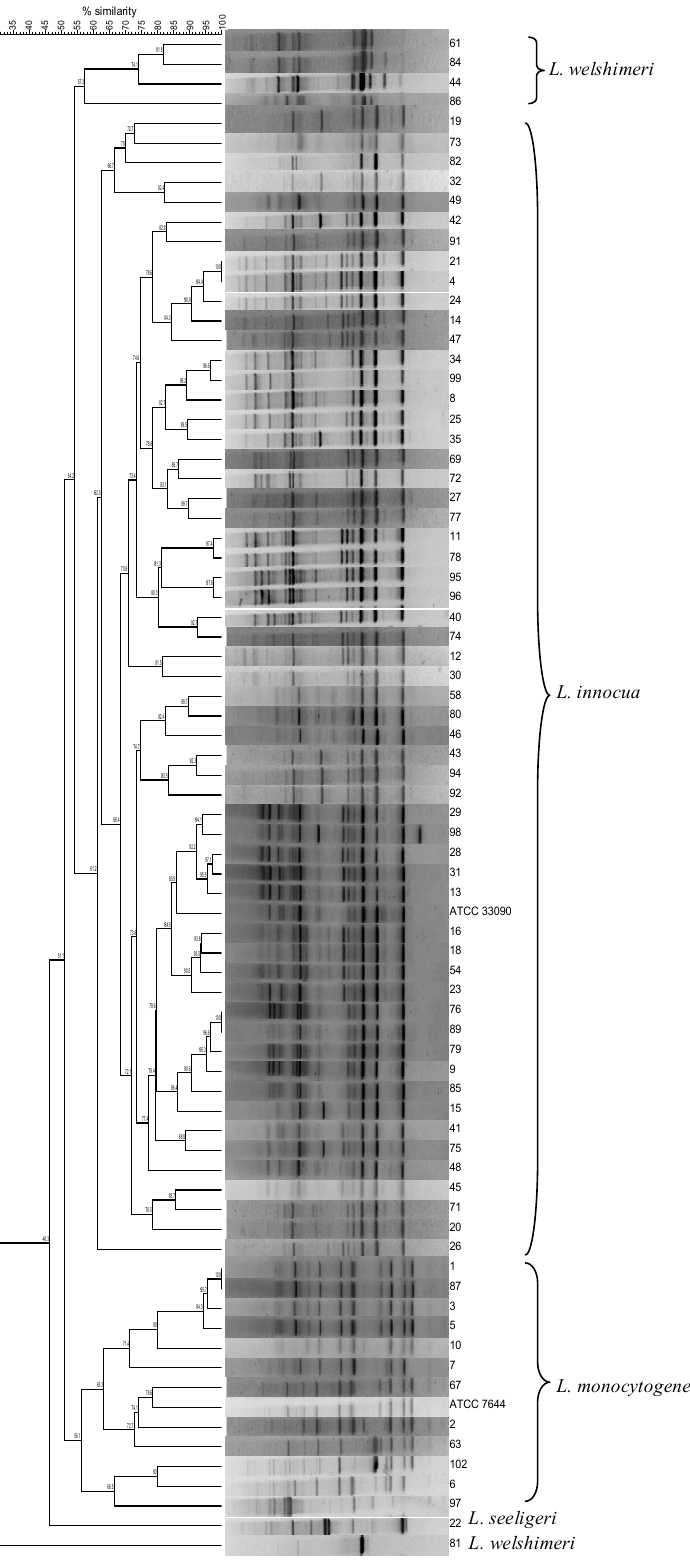
Figure 1. Clustering of Listeria spp. isolates from food and food-production plants based on rep-PCR profiles.